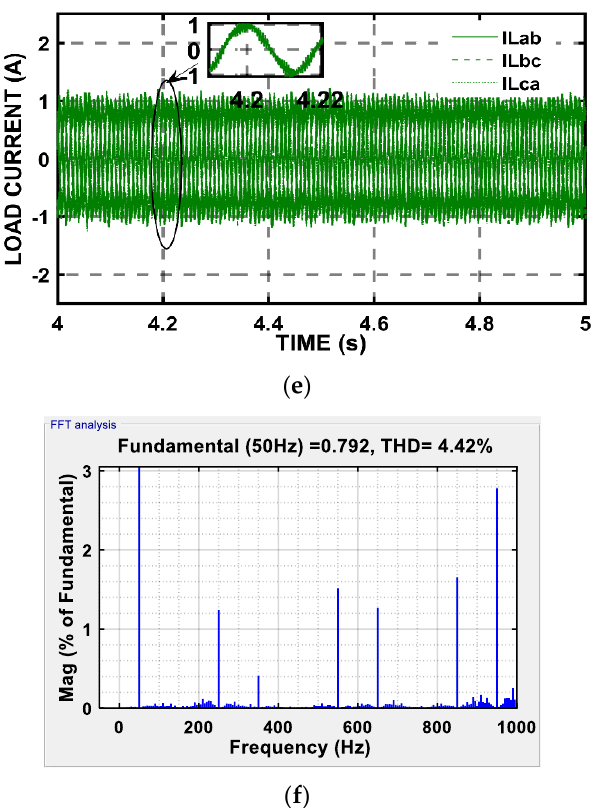
Figure 8. The performance of the drive using a passive filter for case 1. ( a ) Source voltage. ( b ) Source current. ( c ) Speed. ( d ) Torque. ( e ) Load current. ( f ) THD of a source current.